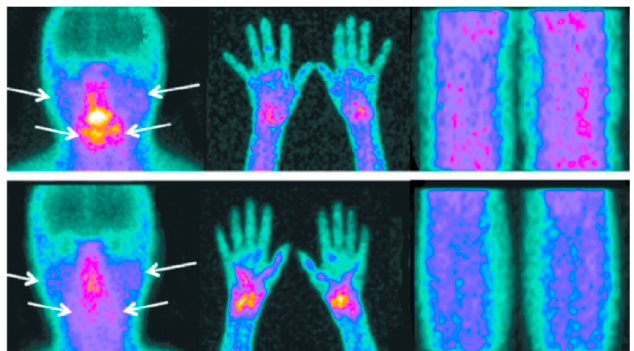
Figure 3. Example of two scans in two patients showing different degrees of 99m Tc-SST uptake in the parotid and submandibular glands (arrows), carpus (both patients positive), and knees (both patients negative).